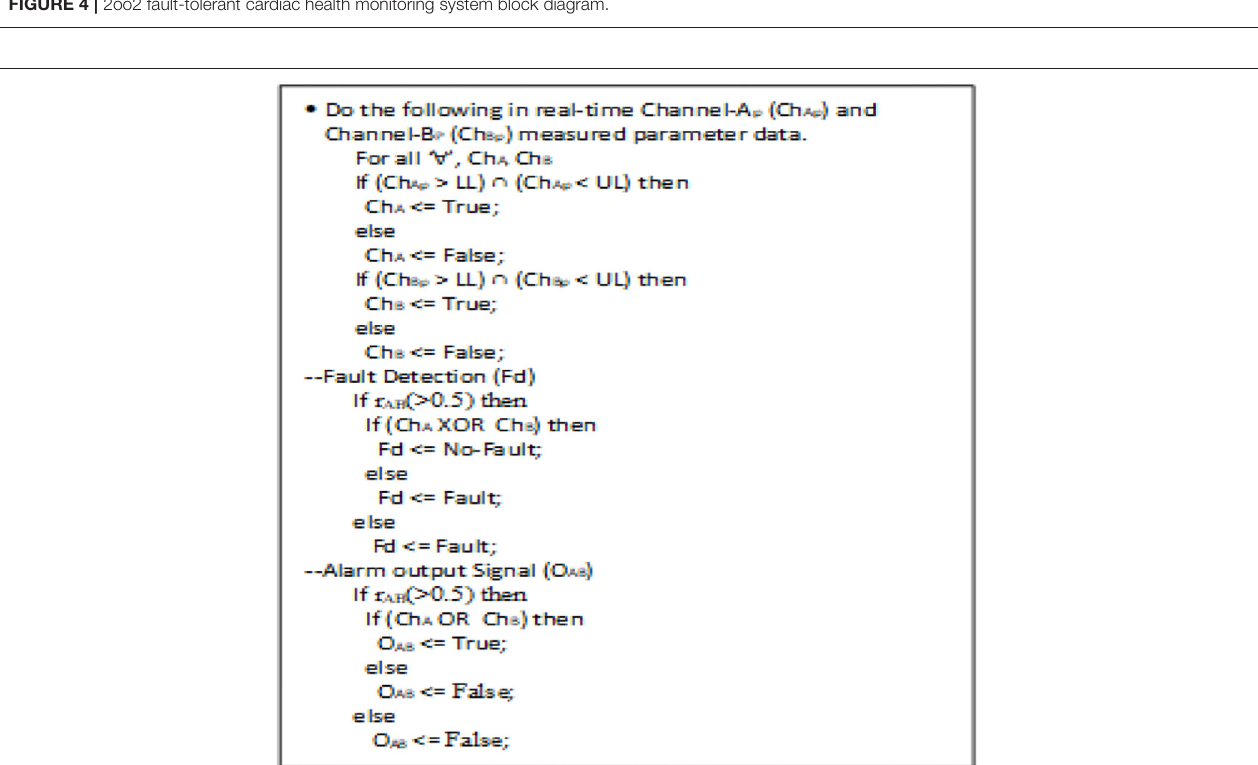
FIGURE 5 | Pseudocode for fault detection analytics and alarm output